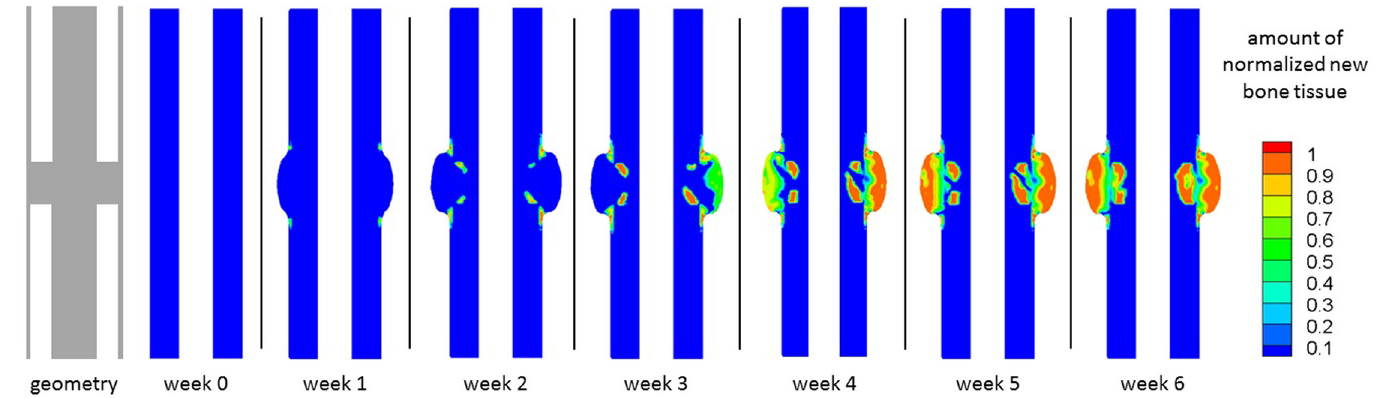
Fig 7. Evolution of normalized new bone tissue in vivo and in silico . fraction measure (blue) in vivo [ 102 ] and predicted in silico (red) for a rat fracture model of